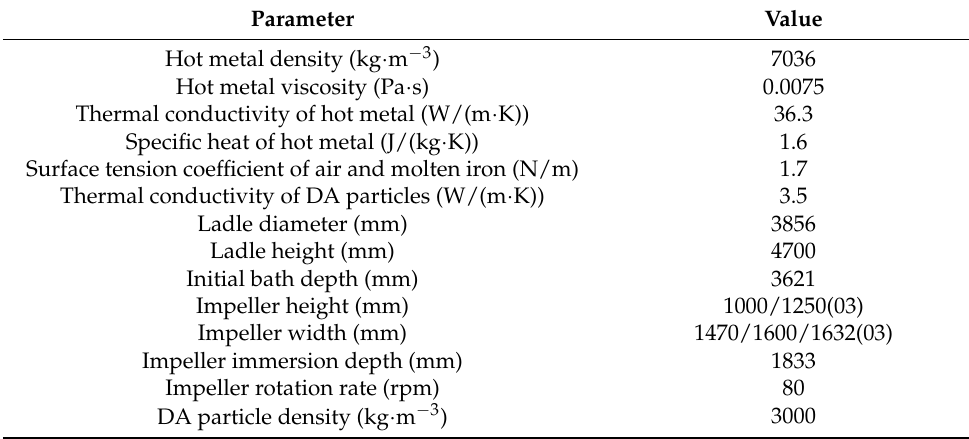
Table 1. Geometric and physical parameters adopted in the numerical simulation.